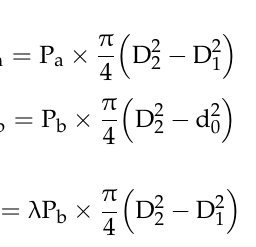
Figure 2. Stress distributions on the rotating ring in a balanced sealing system .